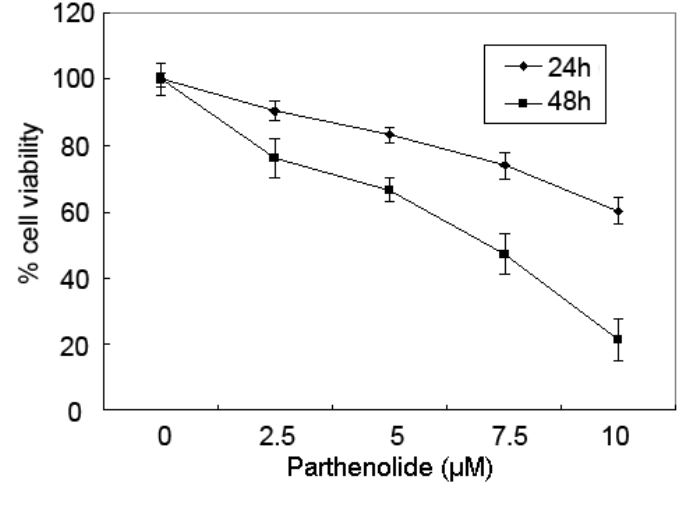
Figure 1. Parthenolide inhibited cell viability of human bladder cancer 5637 cells in a dose- and time-dependent manner. Viability of cells was determined by the MTT